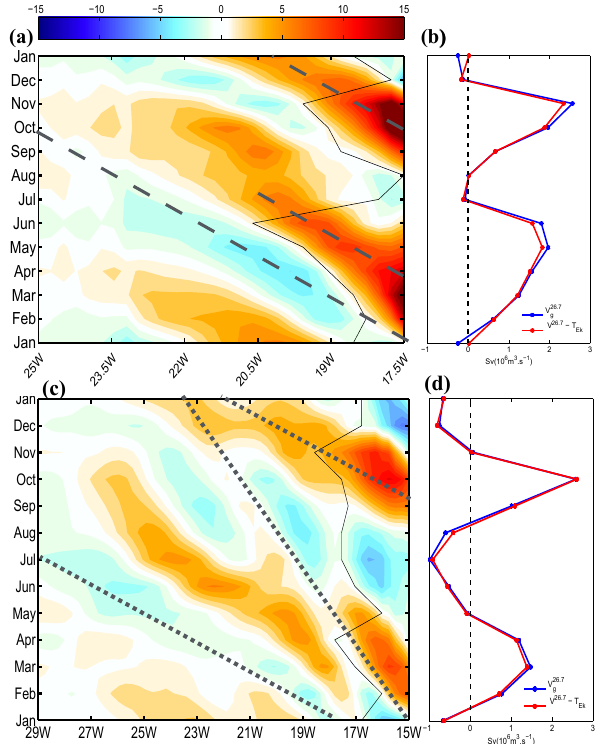
Figure 8. (a, c) Time–longitude diagram of vertically integrated meridional transport (m 2 s − 1 ) averaged along-slope between 13 and 15 ◦ N (a) and between 7 and 9 ◦ N (c) . Propagation speed at 3.5cms − 1 (a) as well as 7.4 and 3cms − 1 ( c ) is shown with dashed lines. These values are the ones we choose as most appropriate to describe the propagation of patterns in the diagrams. (b, d) Associ- ated climatologies of meridional transport integrated vertically and across-shore. Vertical integration is performed from the isopycnal surface σ θ = 26 . 7 up to the bottom of the mixed layer ( a, c and red curve in b, d ) or up to the surface but excluding Ekman transport; i.e., we only take into account the geostrophic flow (blue curve in b, d ). Across-shore integration is performed from the shoreline to the first location where vertically integrated transport vanishes with a maximum longitude range of 3 ◦ (integration limit is indicated with the thin solid line in a and c